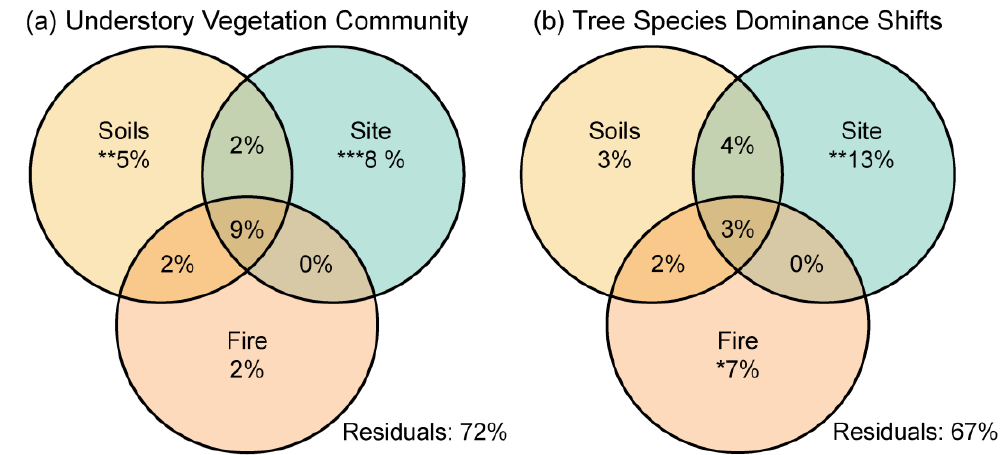
Figure 4. Venn diagrams showing the partitioning of variation in ( a ) post-fire understory vegetation community dissimilarities and ( b ) shifts in tree species dominance, between post-fire soils (Soils); pre-fire forests, site moisture, and climate (Site); burn severity and fire history (Fire); and unexplained residual variance. The significance of unique portions of variance explained is indicated by asterisks (* p = 0.05, ** p = 0.01, *** p = 0.001). The measured and interpolated environmental variables in each explanatory partition are reported in Table 2.